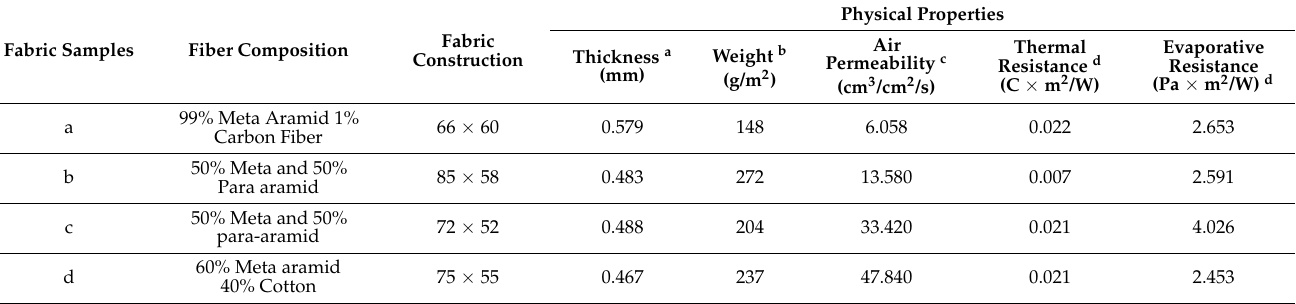
Table 1. Details of the selected fabrics.